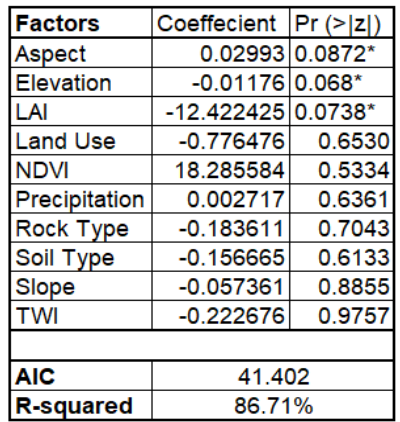
Table 1. The coefficients and probability scores of each factor